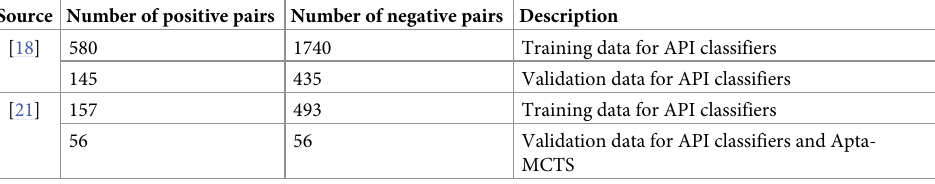
Table 1. The two benchmark API datasets that are used for building two different classification